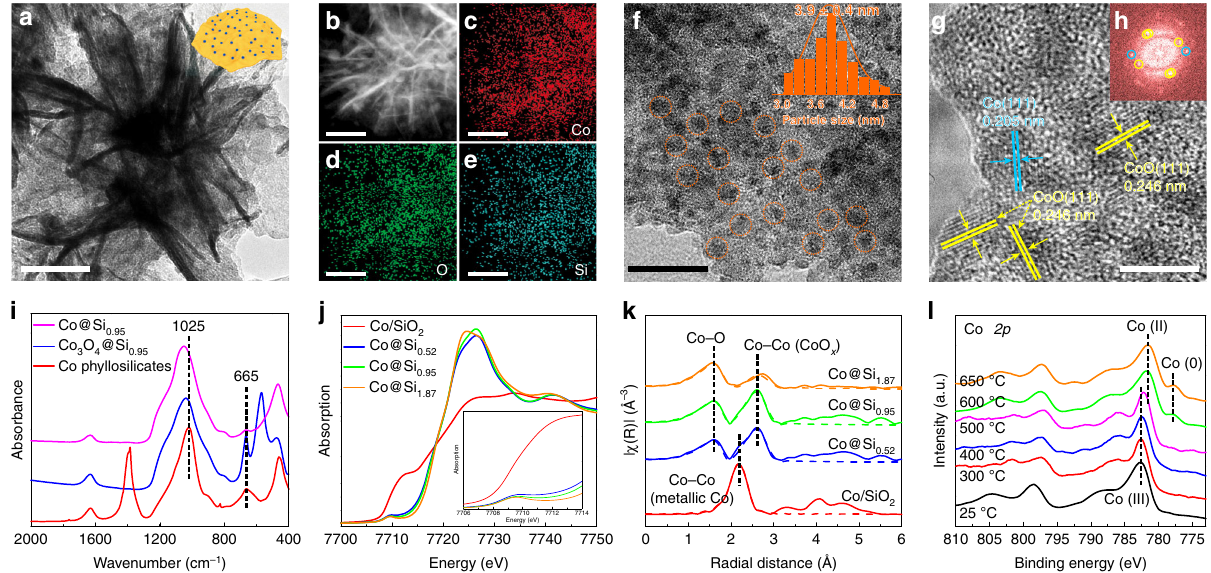
Fig. 3 Structural characterization of Co@Si 0.95 catalyst. a TEM image of Co@Si 0.95 . b – e , b HAADF-STEM image and EDX elemental maps of c Co, d O, and e Si of Co@Si 0.95 . f , g HRTEM images of Co@Si 0.95 . The orange circles highlight the Co nanoparticles (inset of f : size distribution of Co nanoparticles.) h FFT image of the Co nanoparticles corresponding to the HRTEM image in g . Scale bars: 100 nm in a – e , 20 nm in f , and 5 nm in g . i FT-IR spectra of Co@Si 0.95 samples. j , k Co K-edge X-ray absorption spectra. j XANES spectra (inset: enlarged pre-edge region) and k EXAFS spectra with k 2 -weighted data (solid line) and fi t corresponding to recommended model (dashed line) of Co@Si x and Co/SiO 2 samples. l In situ Co 2p XPS spectra of Co 3 O 4 @Si 0.95 under 0.1 mbar of H 2 at various